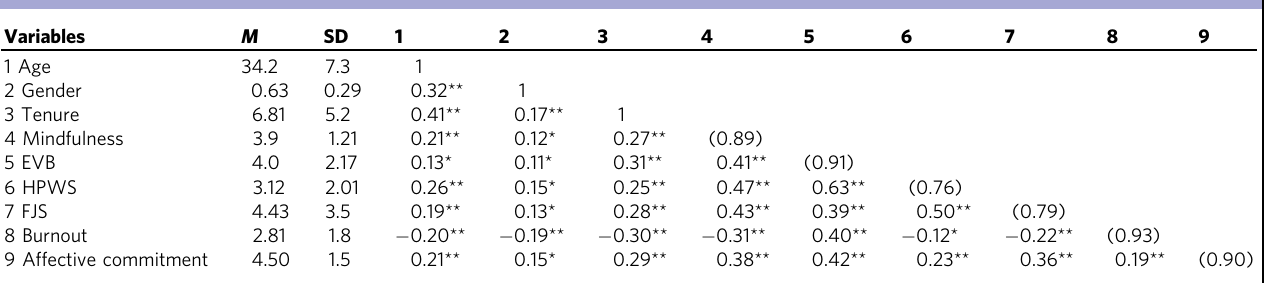
Table 3 Results of descriptive and correlation analysis.